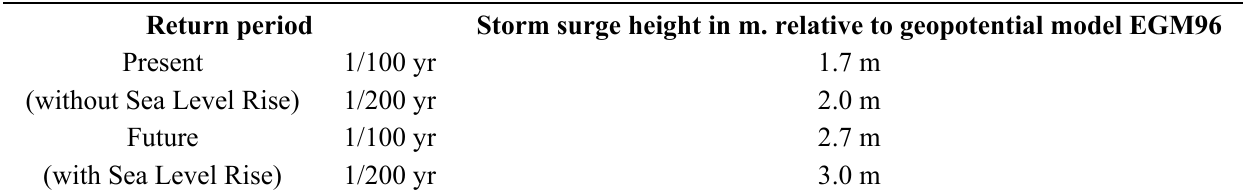
Table 1. Water levels used for the case study of Lagos